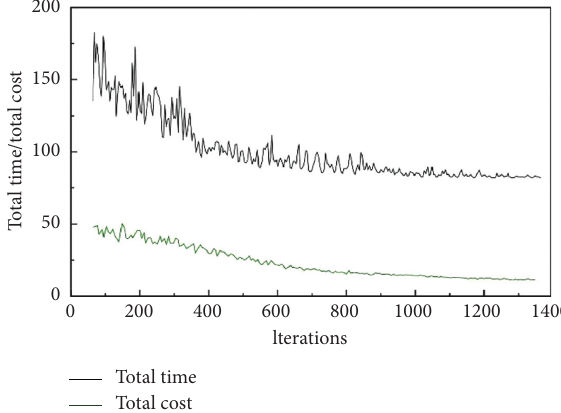
Figure 8: Mean change curve of population objective function.